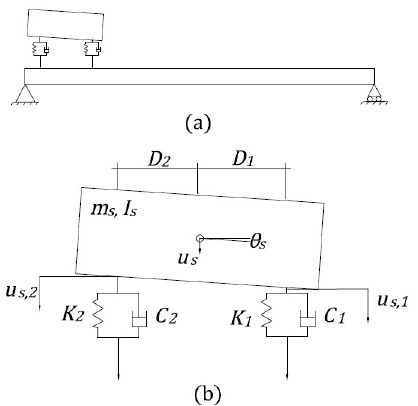
Table 2. Vehicle properties used to calculate MR-IL.